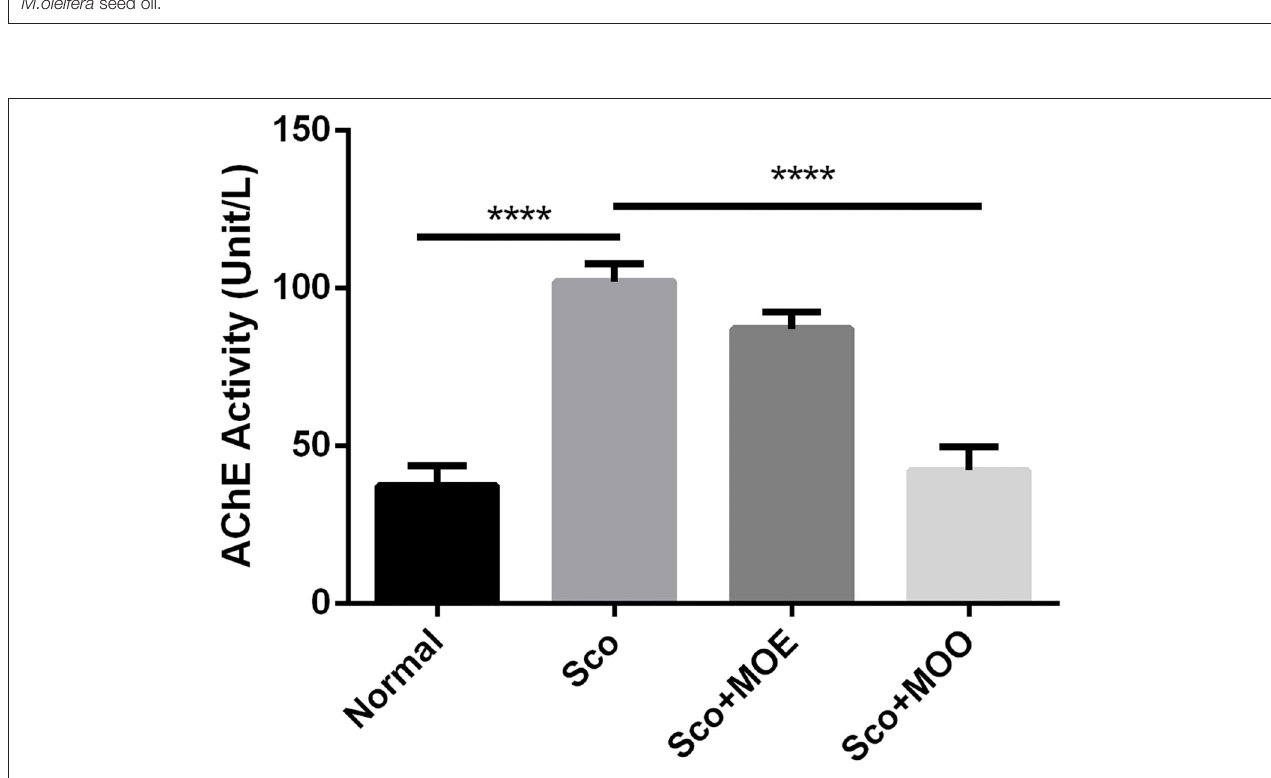
FIGURE 3 | Effects of MOE and MOO on Sco-induced memory impairments in the activity of acethylcholine esterase. Each column represents mean ± SEM of six mice. Data analysis was performed using one way ANOVA, followed by Tukey’s multi comparison test. **** p < 0.0001. MOE, aqueous leaves exctract of M.oleifera ; MOO, M.oleifera seed oil.